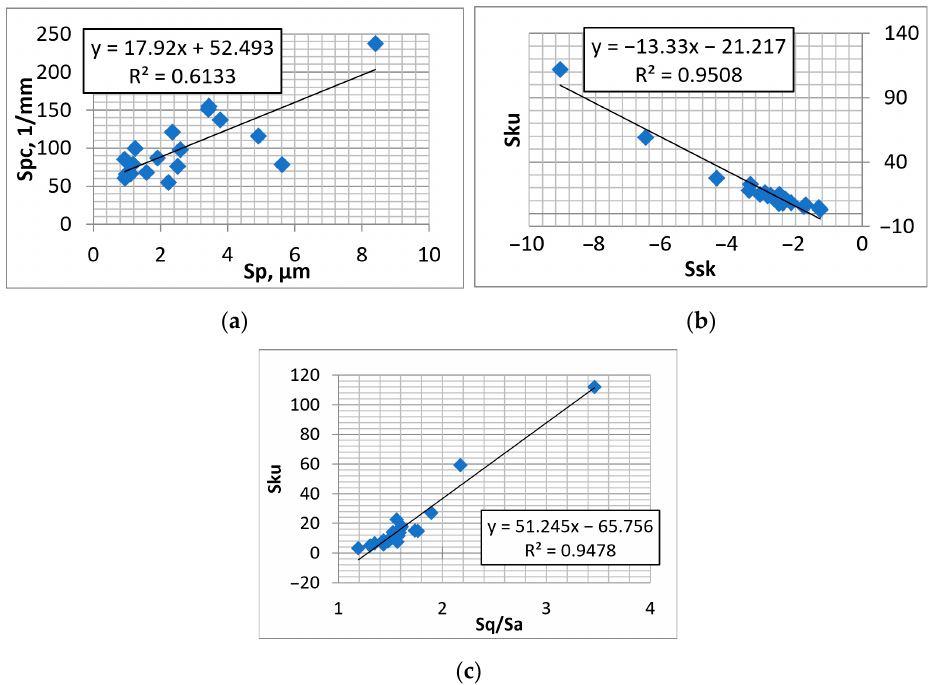
Figure 13. Dependencies between parameters: Sp–Spc ( a ), Ssk–Sku ( b ), and Sq/Sa–Sku ( c ) of the textured surfaces.